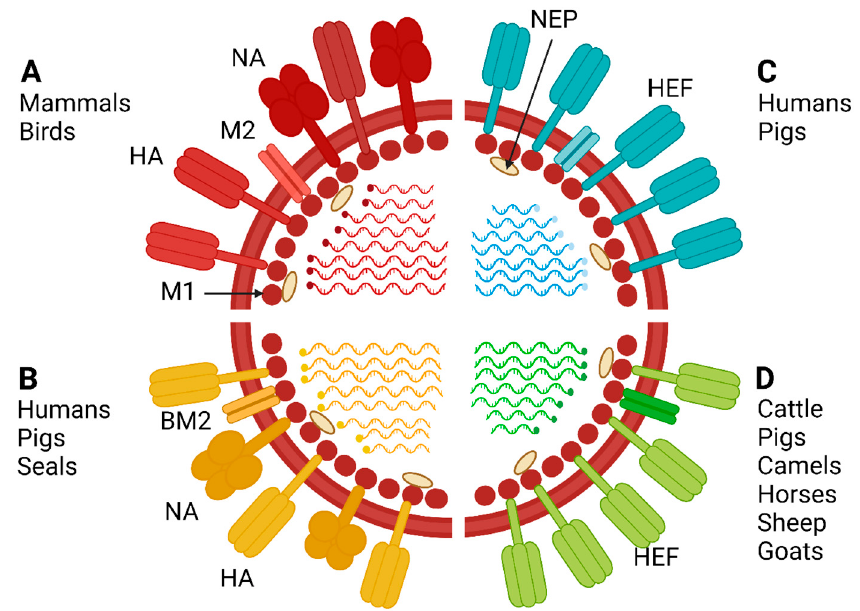
Figure 1. Influenza A, B, C, and D schematic structure and host range. The genome of Influenza A and B is composed of 8 gene segments, while that of influenza C and D is composed of 7 gene segments. Influenza C and D encode hemagglutinin esterase (HEF) protein, which is equivalent to the HA and NA proteins of Influenza A and B. Influenza A infects a wide range of mammals (including humans) and all bird species. The figure was created with BioRender.